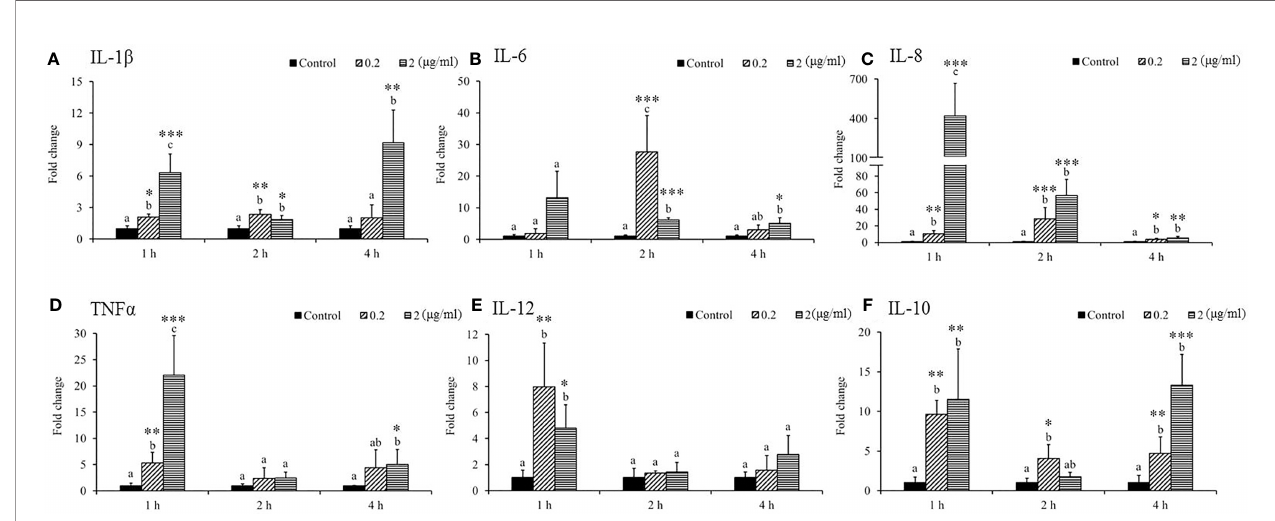
FIGURE 1 | Differential immune gene expression of (A) IL-1 b , (B) IL-6 , (C) IL-8 , (D) TNF a , (E) IL-12 , and (F) IL-10 in Sarcodia suiae water extract (SSWE) treated primary cobia head kidney (HK) cells. Cobia HK cells were stimulated with L-15 containing 0 (Control), 0.2 and 2 m g/ml of SSWE and expression of indicated genes were measured 1, 2 and 4 hours post stimulation. The expression values from three fi sh are shown as mean + SEM fold change relative to the control group. Signi fi cant differences between samples and their time matched control group are shown with asterisks (* p < 0.05 , ** p < 0.01 and *** p < 0.001 ) and differences between groups are indicated by different